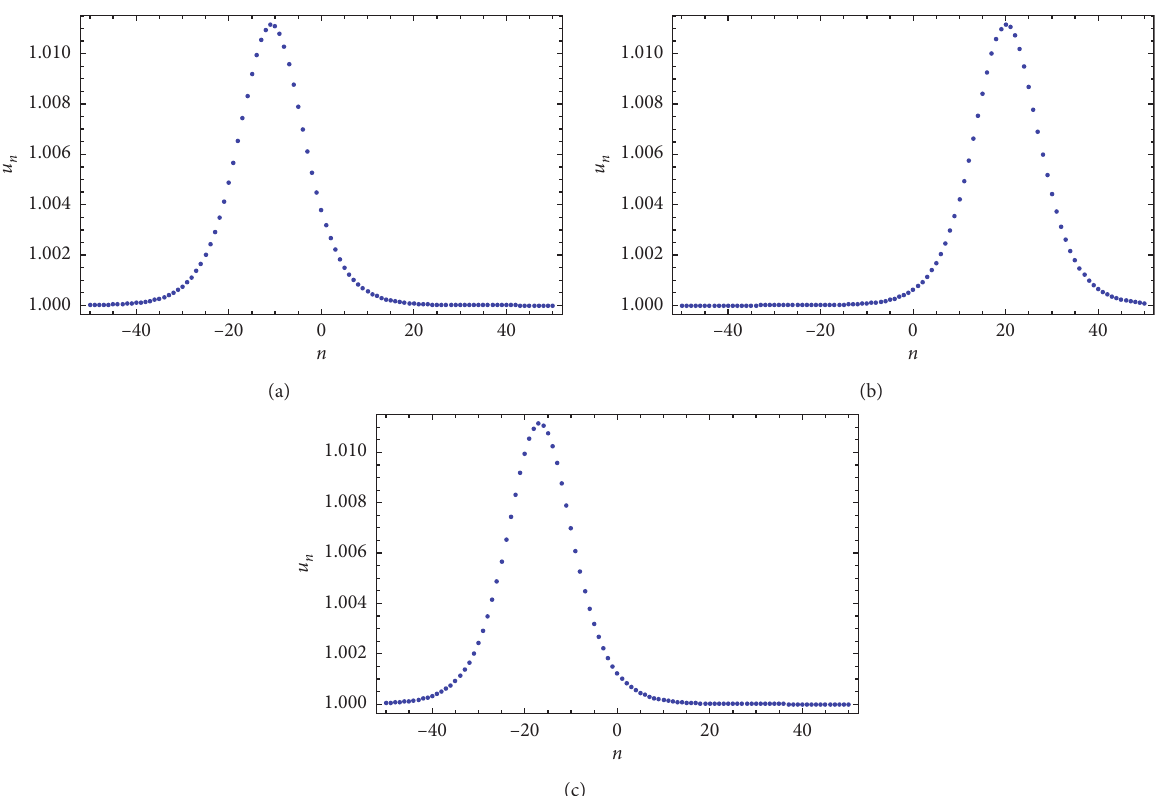
Figure 3: Dynamical evolution of semidiscrete one-soliton solution (69) with the parameters α c ( 0 ) � 1, k � 3, and z 1